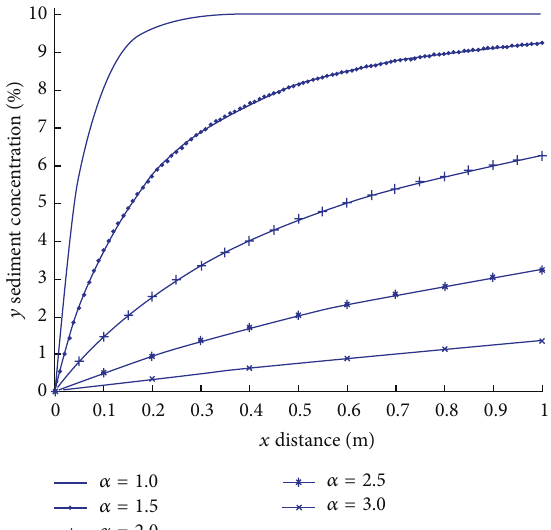
Figure 4: Sediment concentration distribution of initial transport along the path 𝑥 ( m ) , 𝑦 sediment concentration (%).